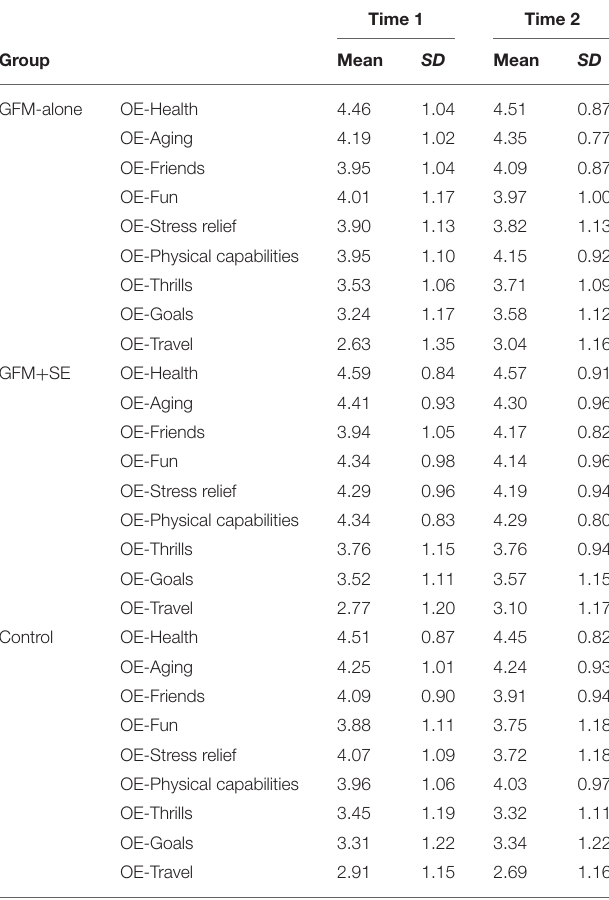
TABLE 2 | Descriptive statistics for outcome expectancy variables at multiple time